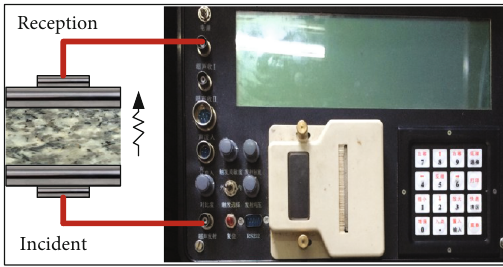
Figure 6: Measurement of ultrasonic wave velocity.